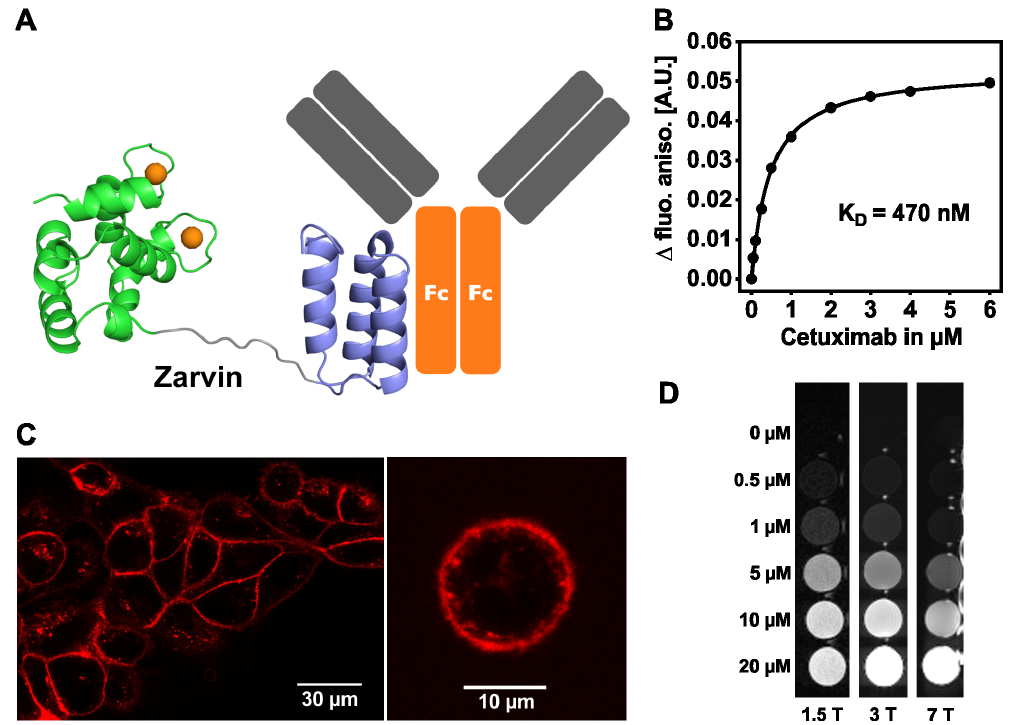
Figure 1. Binding properties and relaxometric properties of Zarvin. (A) Cartoon representation of Zarvin bound to the F c part of an IgG antibody. Two calcium ions (spheres) are bound to Parvalbumin (green), which is connected with the Z domain (violet) via a decaglycine linker (grey). (B) Fluorescence anisotropy titration experiment. Increasing amounts of the monoclonal IgG antibody Cetuximab were added to a 100 nM concentration of Zarvin-Atto-465. (C) Confocal microscopic analysis of the complex Cetuximab:Zarvin-D72C-Atto 594 binding to the EGF receptor located in the cell membrane of A431 cells. Left, cell assembly; right, single cell; control experiments (Figure S4) (D) Relaxometric properties of Zarvin:(Gd 3 + ) 2 at three different field strengths employing an inversion recovery TSE experiment. A diluted solution of rising concentrations of Zarvin:(Gd 3 + ) 2 was investigated to find the limiting concentration which still produces a visible contrast towards the buffer control (0 m M). The picture is displayed with an inversion time TI which zeroes the signal of the buffer control (appears black).